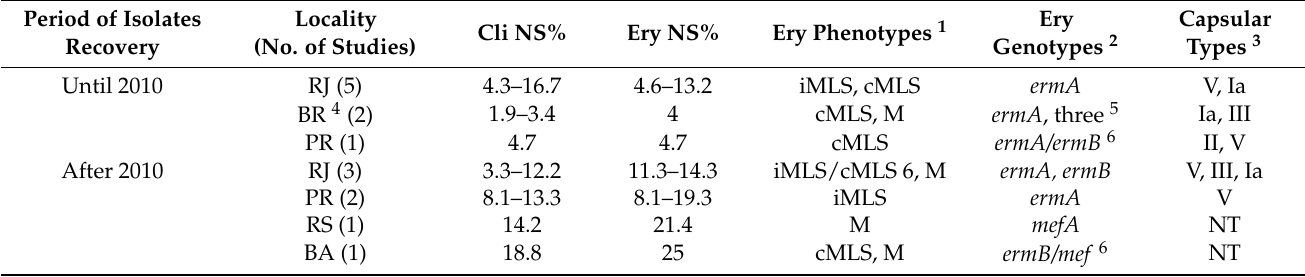
Table 3. Prevalence and characteristics of erythromycin and clindamycin non-susceptible S. agalactiae recovered in Brazil. Period of Isolates